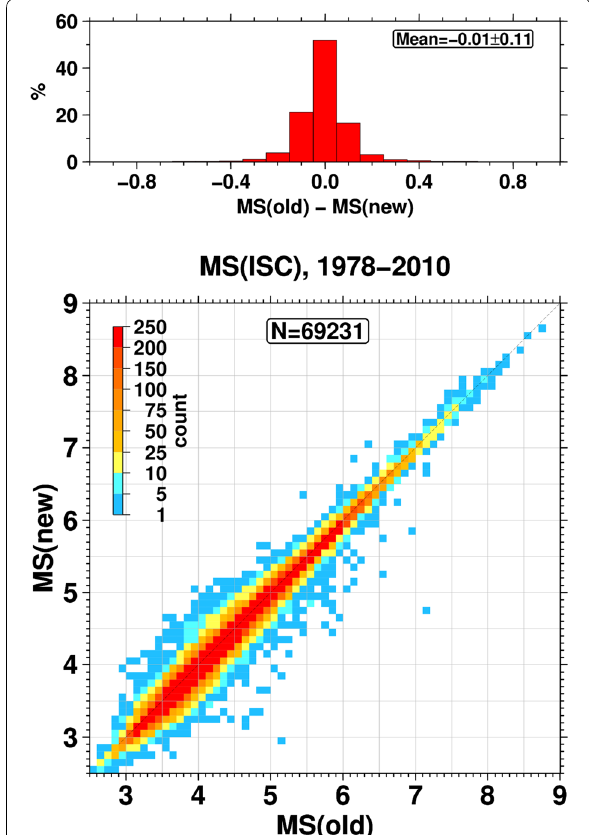
Fig. 12 Comparative analysis of ISC mb (1964–2010) for matching 391,570 events in the original and rebuilt ISC